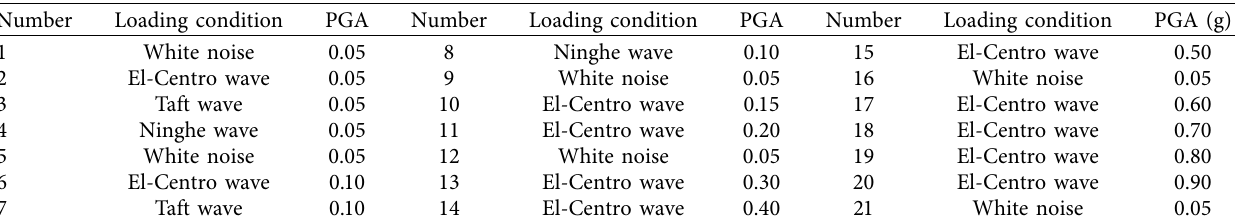
Table 5: Loading procedure.